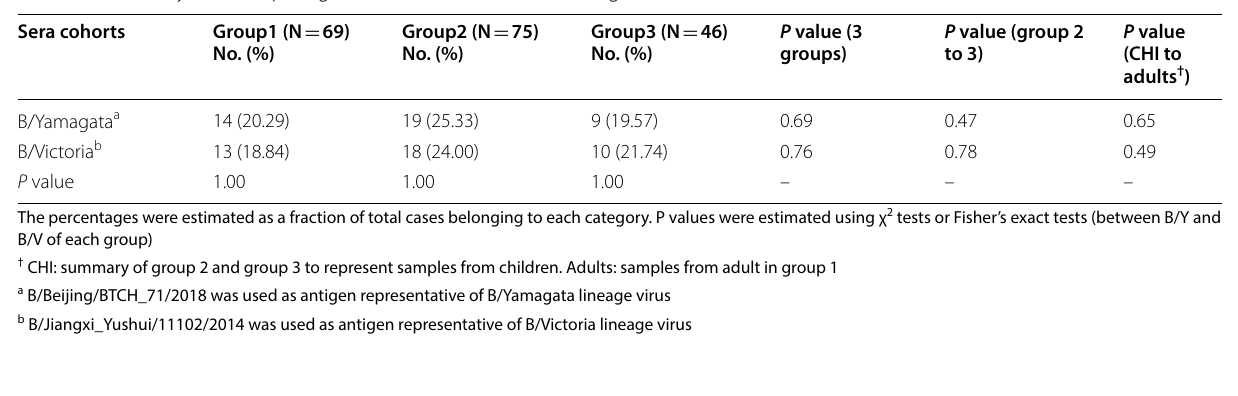
Table 1 Summary and comparing of HI titers to B/Y and B/V lineages in 2016–2017